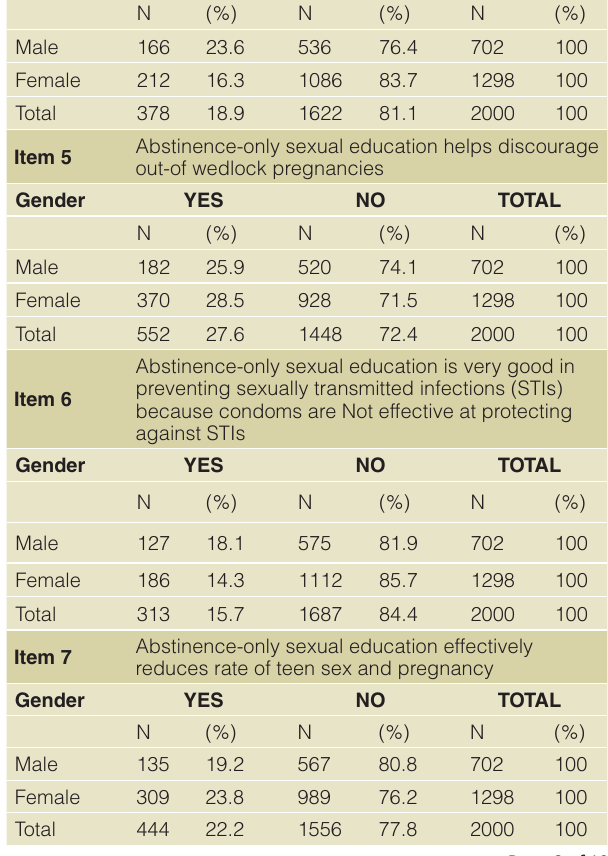
Table 8. Perspective of adolescents according to gender on the advantages of abstinence-only sexual